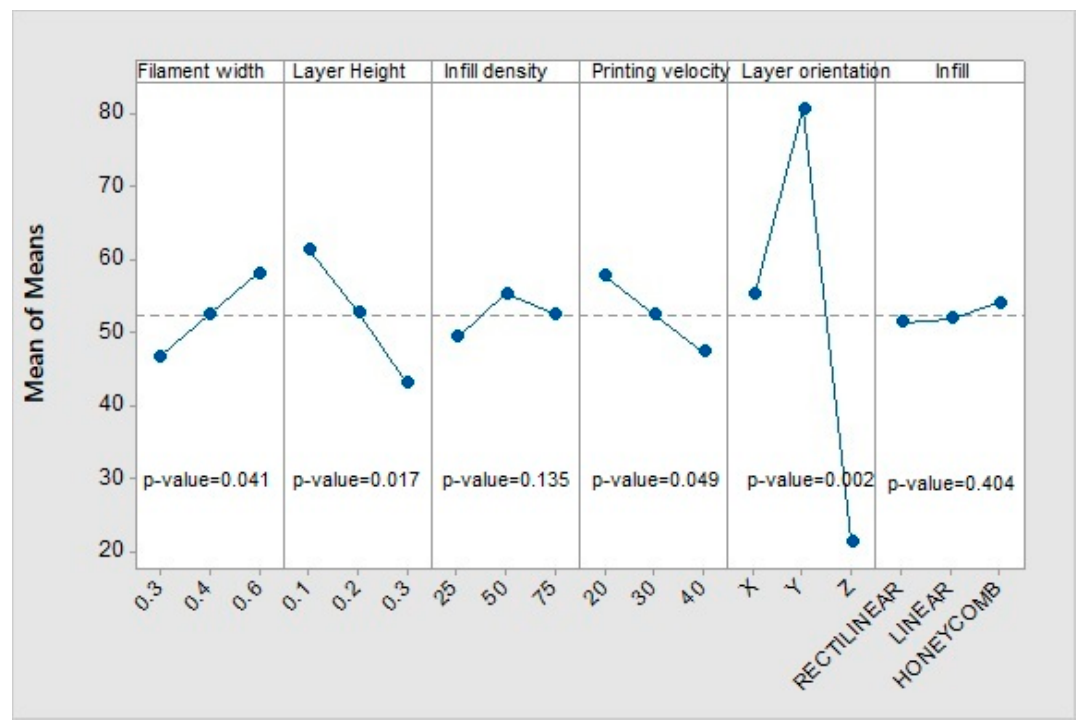
ff ects of means for yield strength. Figure 11. Main effects of means for yield strength. Figure 11. Main e